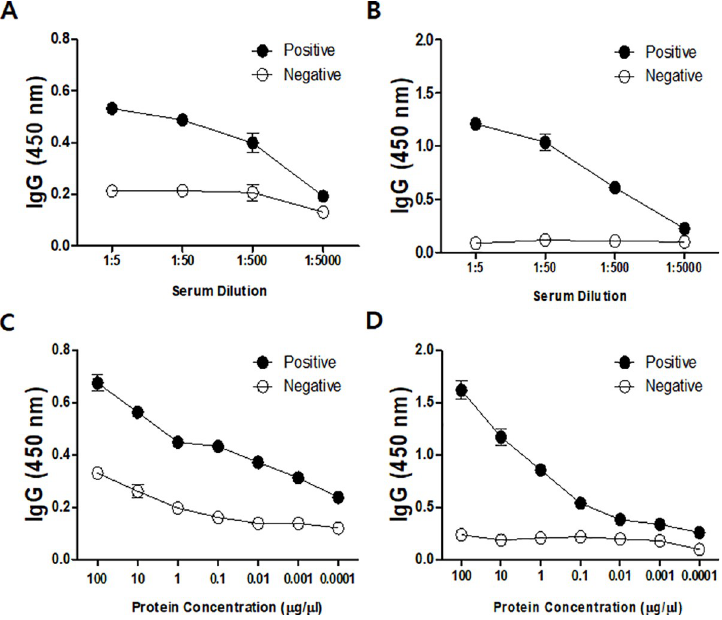
Fig 7. A . castellanii chorismate mutase-specific IgG response. The chorismate mutase polyclonal antibody was titrated using A . castellanii cell lysates (A) and conditioned media (B). Sensitivity of the antibody was also determined using cell lysates (C) and conditioned media (D). positive; immunized serum, negative; non-immuned serum.